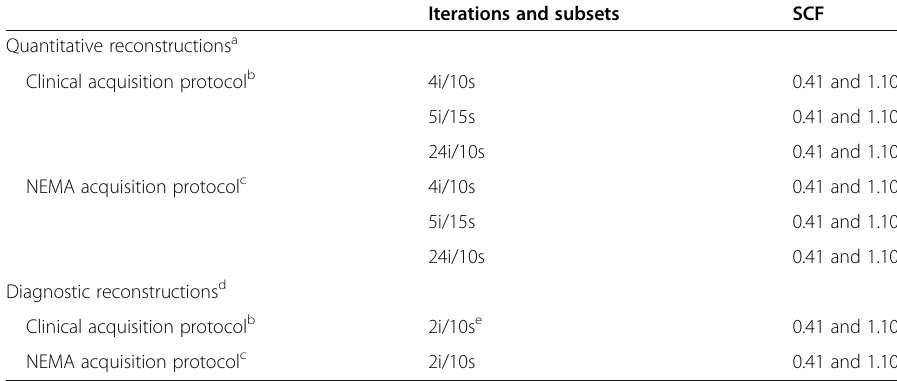
Table 1 Examined reconstruction protocols ( n = 16) Iterations and subsets